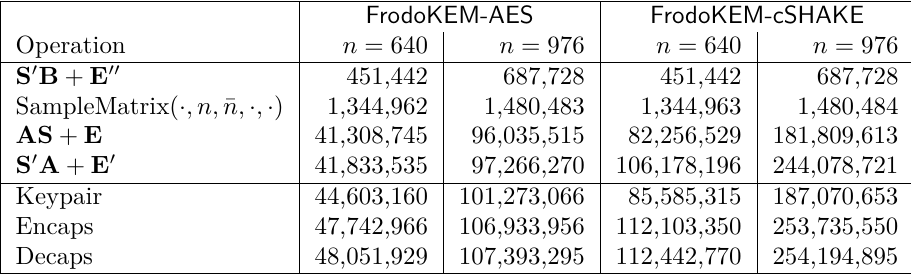
Table 5: Cycle counts for our microcontroller implementation measured at a clock frequency of 168 Mhz.